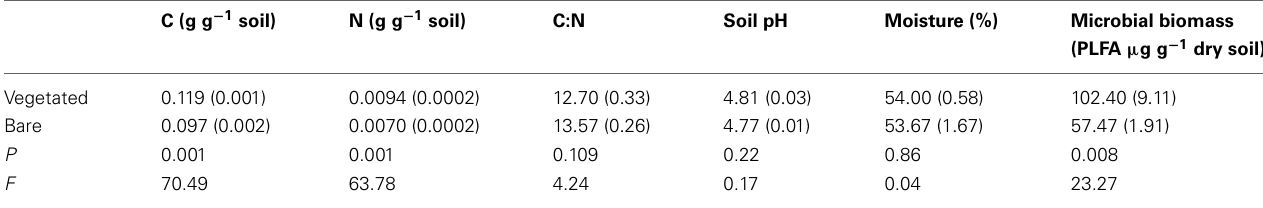
Table 1 | Mean soil properties in vegetated and bare soils.